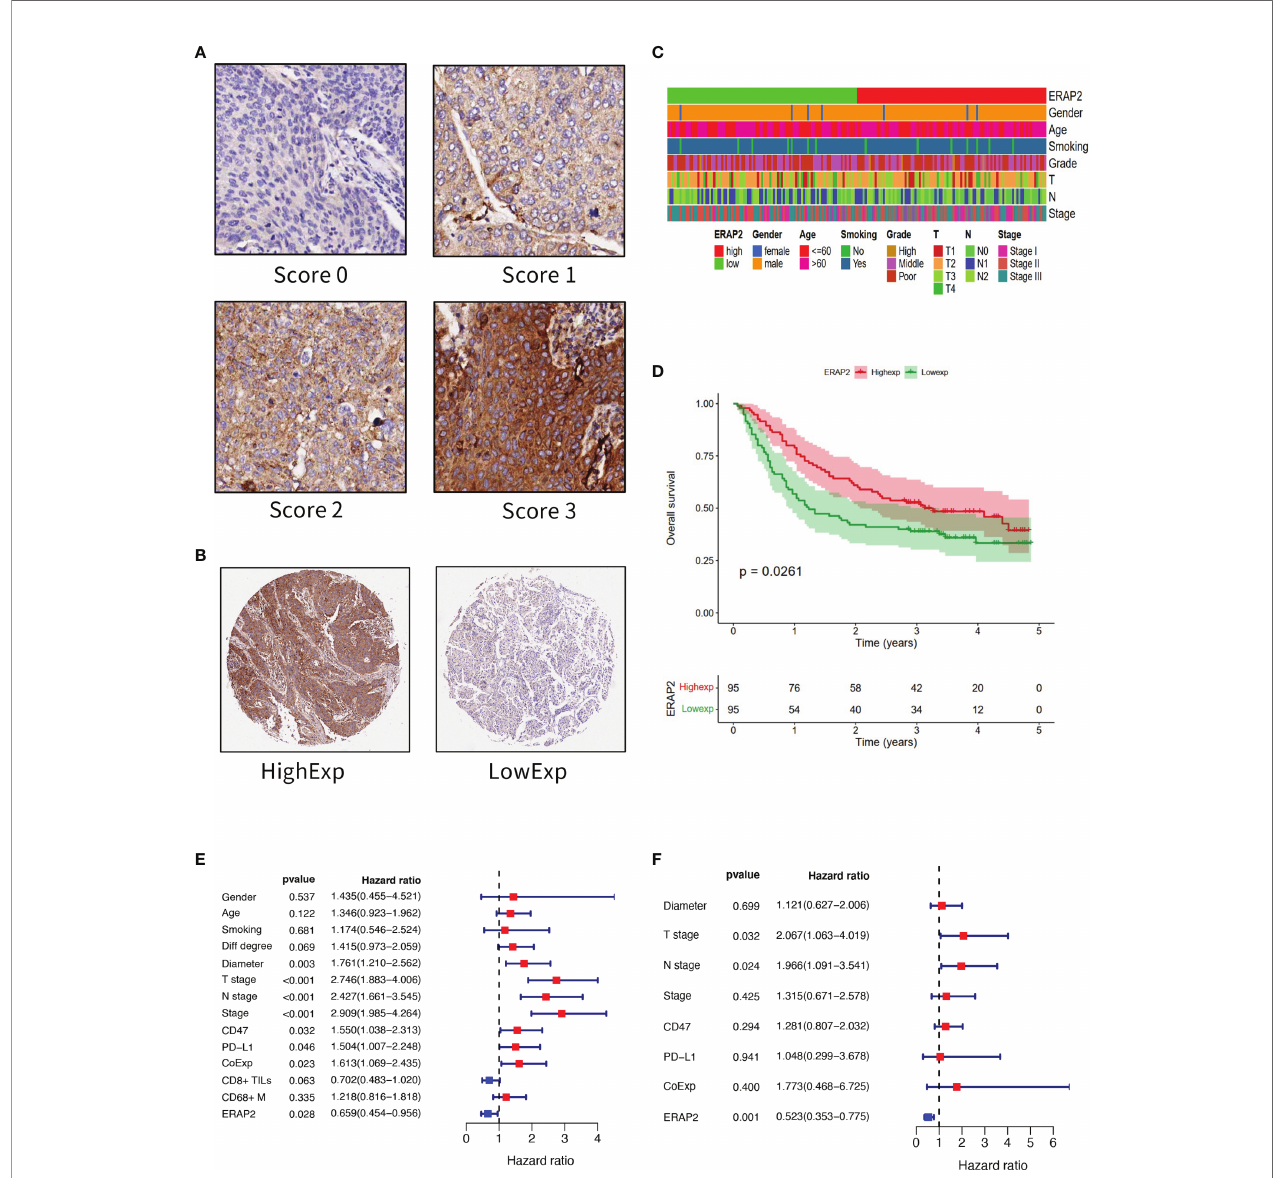
FIGURE 2 | ERAP2 expression in SqCLC tumor microarray (TMA). (A) ERAP2 staining intensity scoring standard. ERAP2 expression was graded into 4 categories: 0, 1, 2, and 3 according to the staining intensity. The larger number represented higher ERAP2 staining intensity (100×). The fi nal score of samples is evaluated by multiplying the grade and corresponding area percentages. (B) Example of high and low ERAP2 expression in TMA. Left, high expression sample. Right, low expression sample (20×). (C) Clinicopathological information related heatmap of SqCLC TMA. (D) K-M curve showing the overall survival in SqCLC TMA strati fi ed by ERAP2 expression. Red, ERAP2 high expression group. Green, low expression group. (E) Univariate analysis forest plot of clinicopathological factors, ERAP2 expression, and other immune markers ’ expression in SqCLC TMA. CoExp, PD-L1, and CD47 co-expression. CD8+ TILs, CD8+ tumor in fi ltration lymphocytes. CD68+ M, CD68+ in fi ltration macrophages in fi ltration level. The red square represents risk factors for prognosis, while the blue square represents protective factors for patients. (F) Multivariate analysis forest plot offactors, which could predict the overall survival in the univariate analysis. CoExp, PD-L1, and CD47 co-expression. CD8+ TILs, CD8+ tumor in fi ltration lymphocytes. The red square represents risk factors for prognosis, while the blue square represents protective factors for